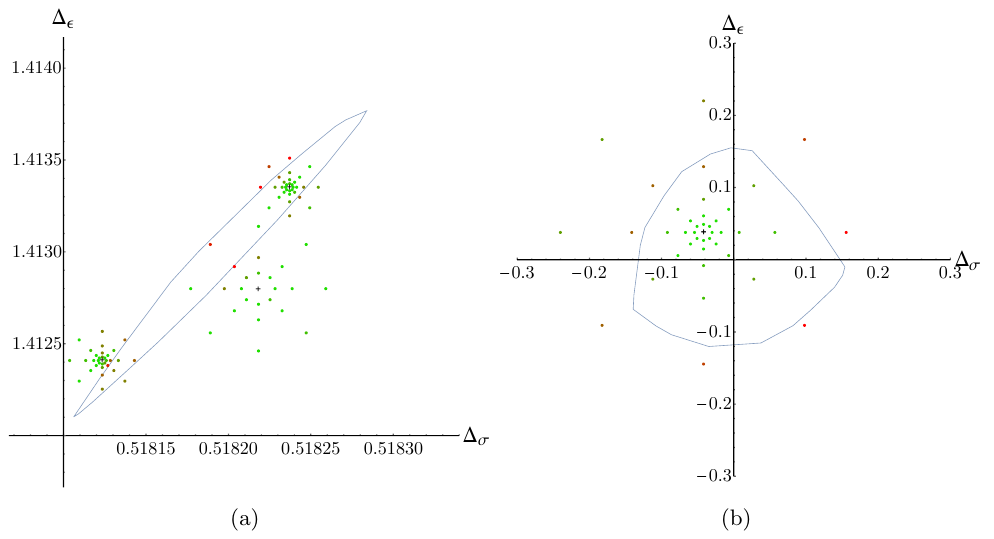
Figure 6 . Hot-starting e(cid:11)ectiveness for di(cid:11)erent nearby checkpoints. The blue line is the boundary of the 3d Ising from (cid:27); (cid:15) mixed correlator bootstrap. The setup is the same as that of the dark blue region of (cid:12)gure 3 in [5] except n max = 10 (i.e. (cid:3) = 19). We (cid:12)x P 0 (indicated by a cross) to be various points and hot-start the P 0 computation with checkpoints taken from nearby points P i around P 0 . The color of P i indicates how many SDPB iterations is needed for the hot-started computation. Red corresponds to 8 iterations, while green corresponds to 1 iteration. Without